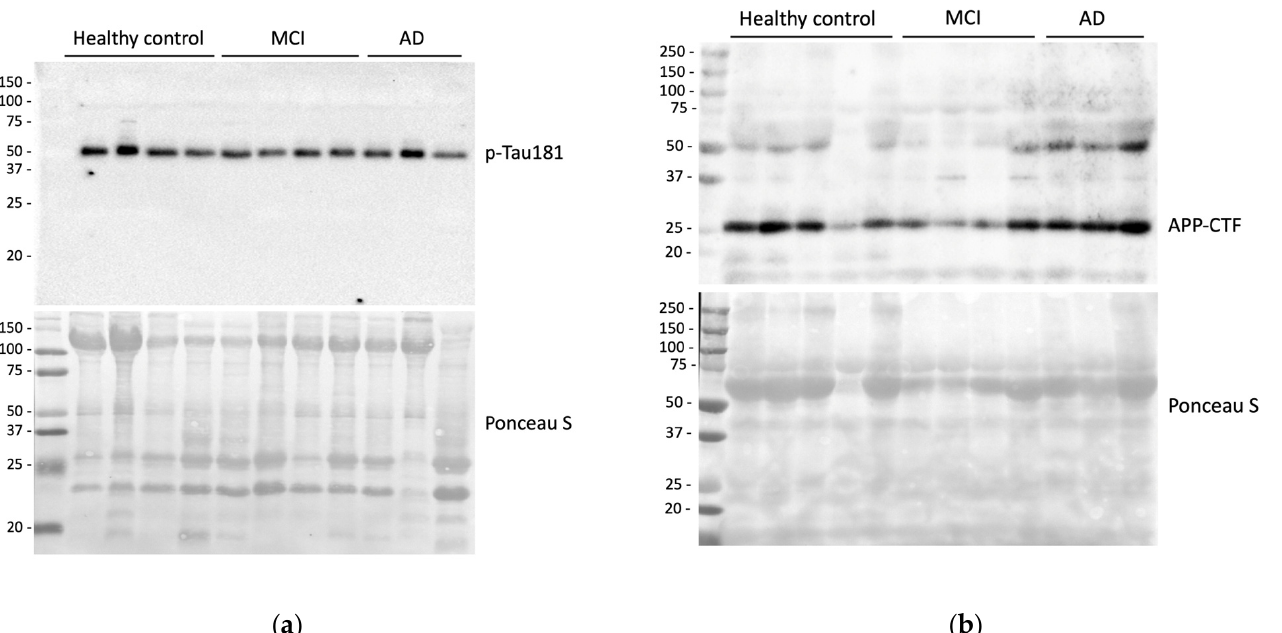
Figure 5. ( a ) Representative Western blot of p-tau181 in control subjects (Healthy control), mild cognitive impairment due to Alzheimer’s disease (MCI), and Alzheimer’s disease patients (AD). p-tau181 detection was carried out by probing the nitrocellulose membrane with a specific antibody, as reported in the Materials and Methods section. Ponceau S staining was employed as an internal loading control to normalize the intensity of p-tau181 bands. ( b ) Representative Western blot of APP cleavage prod- ucts in control subjects (Healthy control), mild cognitive impairment due to Alzheimer’s disease